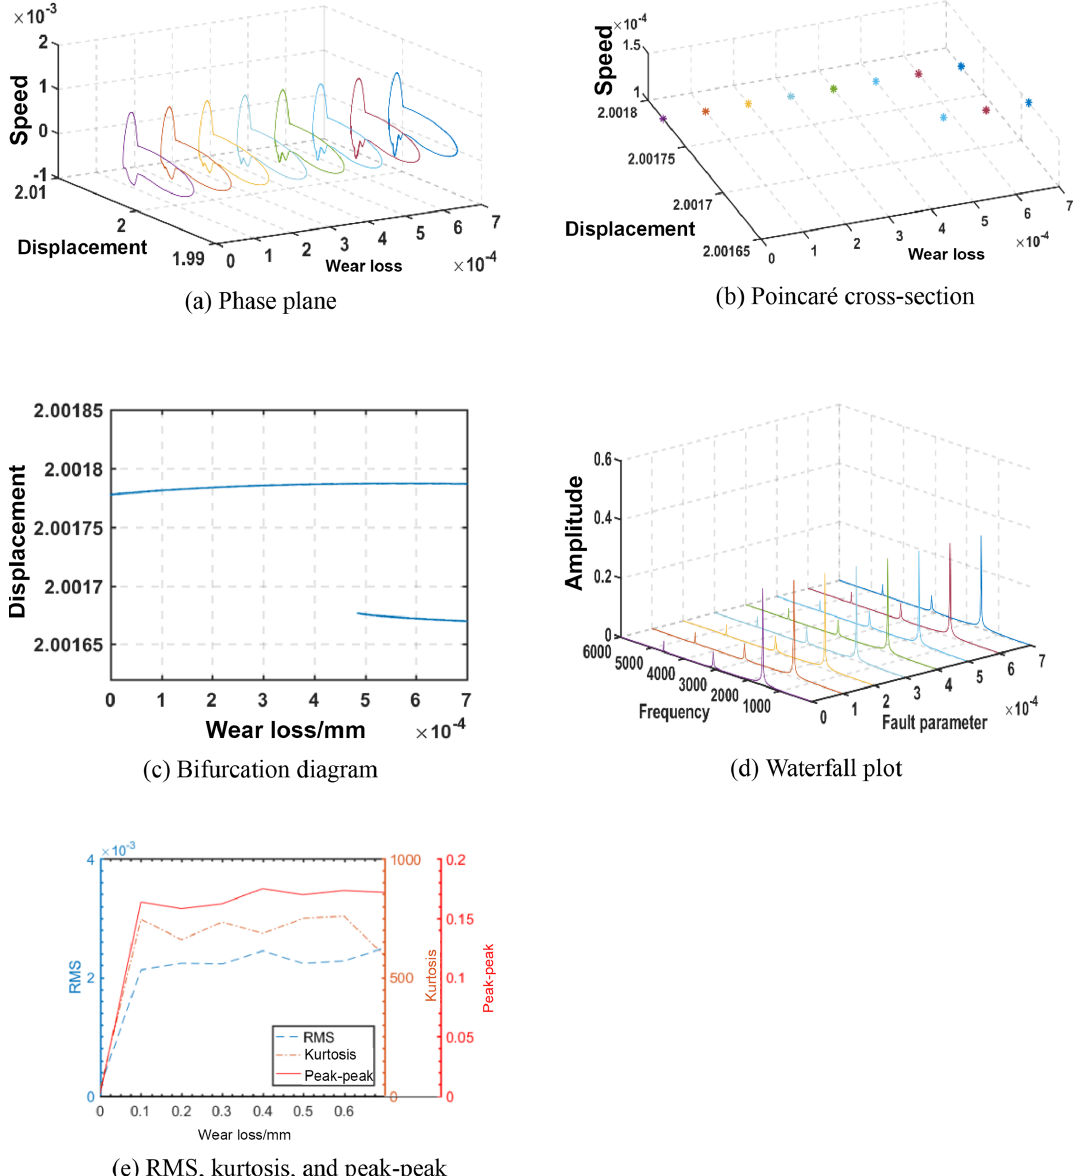
Figure 9. System response changing with wear loss at w k = 43 Hertz.